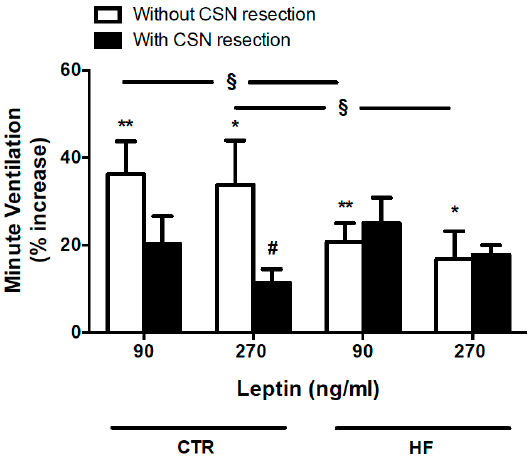
Figure 3. E ff ect of carotid sinus nerve resection (CSN) on leptin e ff ects on ventilation in control (CTR) and high-fat (HF) animals. Leptin (90 and 270 ng / mL) was administrated intracarotidally, as a bolus in anesthetized animals with pentobarbital (60 mg / kg i.p.), as previously described by Ribeiro et al. [13,22]. CSN resection was performed acutely prior to leptin administration. HF animals were submitted to a lipid-rich diet (60% energy from fat) for 3 weeks. Data are presented as mean ± SEM of 5–8 control and 3–5 HF animals. Two-way ANOVA with Bonferroni multiple comparison tests: * p < 0.05, ** p < 0.01, leptin (ng / mL) baseline vs. diet or diet plus leptin; # p < 0.01 without CSN resection vs. with CSN resection; § p < 0.05 control vs. HF